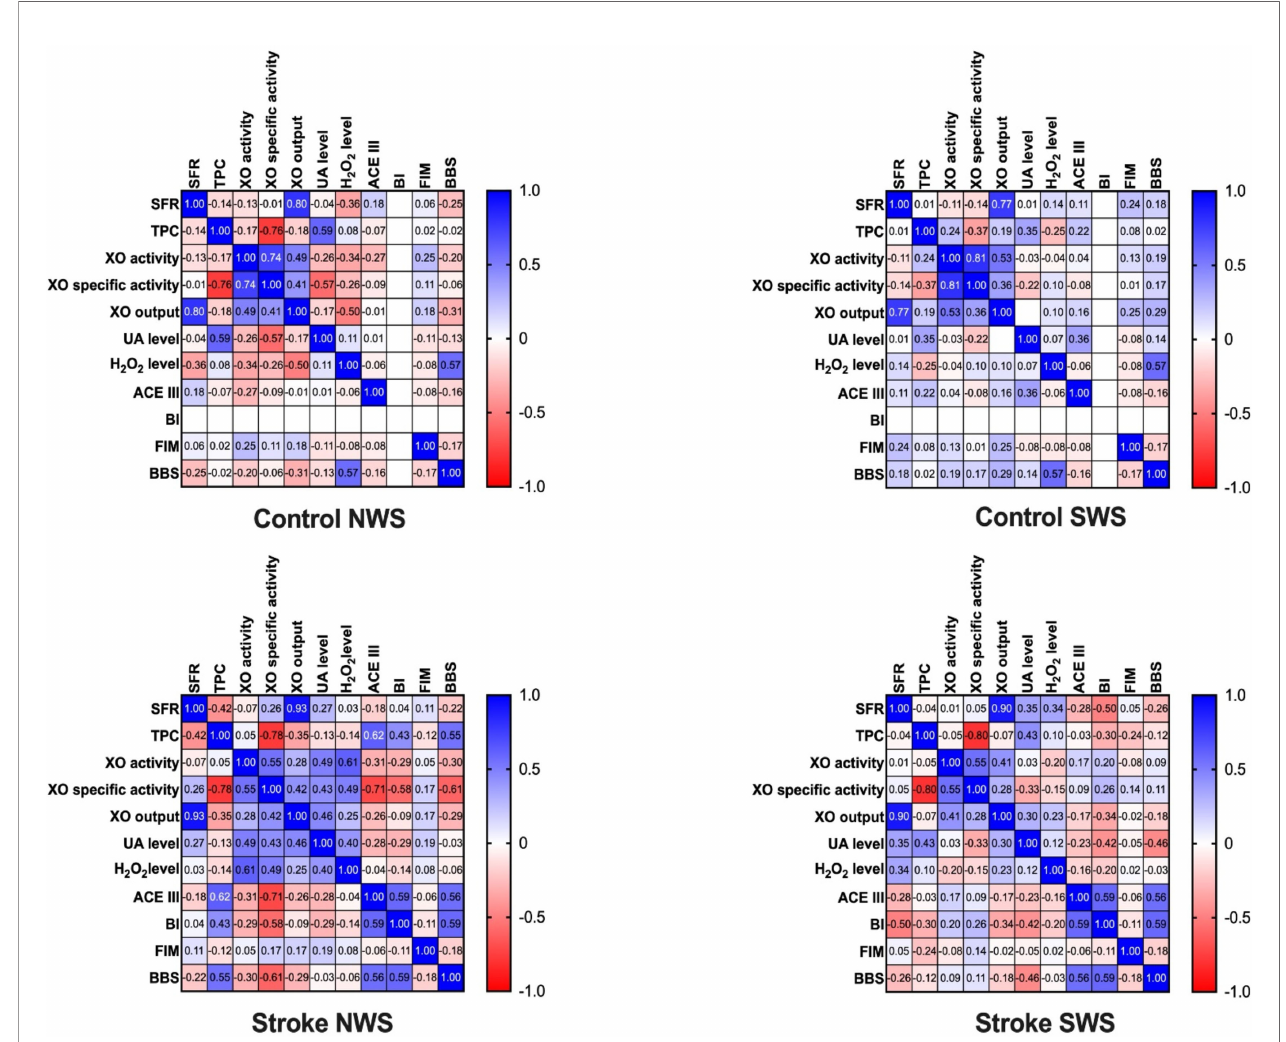
FIGURE 2 | Correlations between salivary gland function, salivary ischemia biomarkers, and clinical parameters. ACE III, Addenbrooke ’ s Cognitive Examination III; BBS, the Berg Balance Scale; BI, Barthel Index; FIM, functional independence measure; H 2 O 2 , hydrogen peroxide; NWS, non-stimulated whole saliva; SFR, salivary fl ow rate; SWS, stimulated whole saliva; TPC, total protein content; UA, uric acid; XO, xanthine